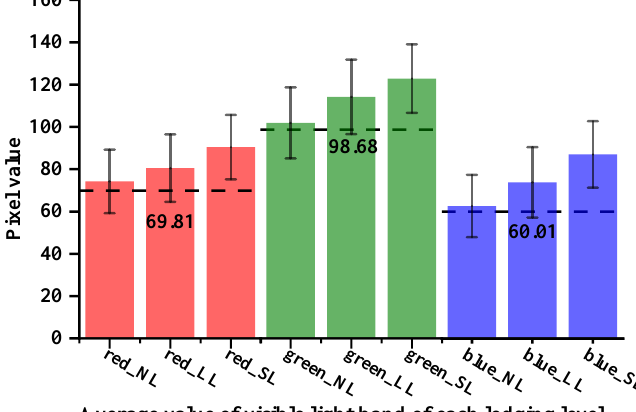
Figure 10. Histogram of average gray values of red, green, and blue bands for the various degrees of lodging. The pixel value of each band increases with increasing degree of lodging; the black dotted lines indicate the average pixel value of the three bands prior to lodging.